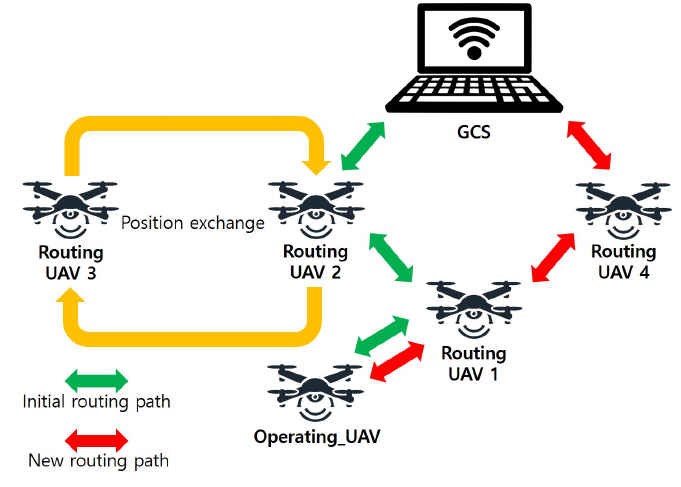
Figure 7. Simulation